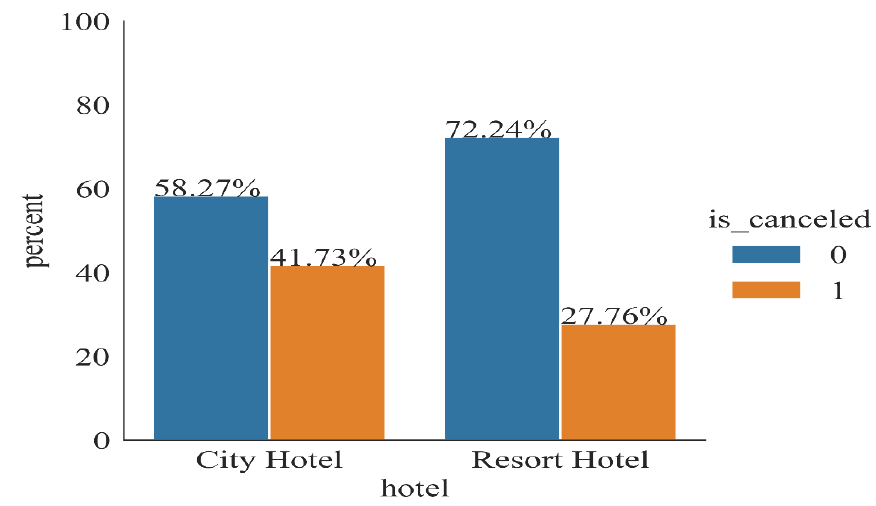
Figure 2. Distribution of examples for hotels H1 and H2.